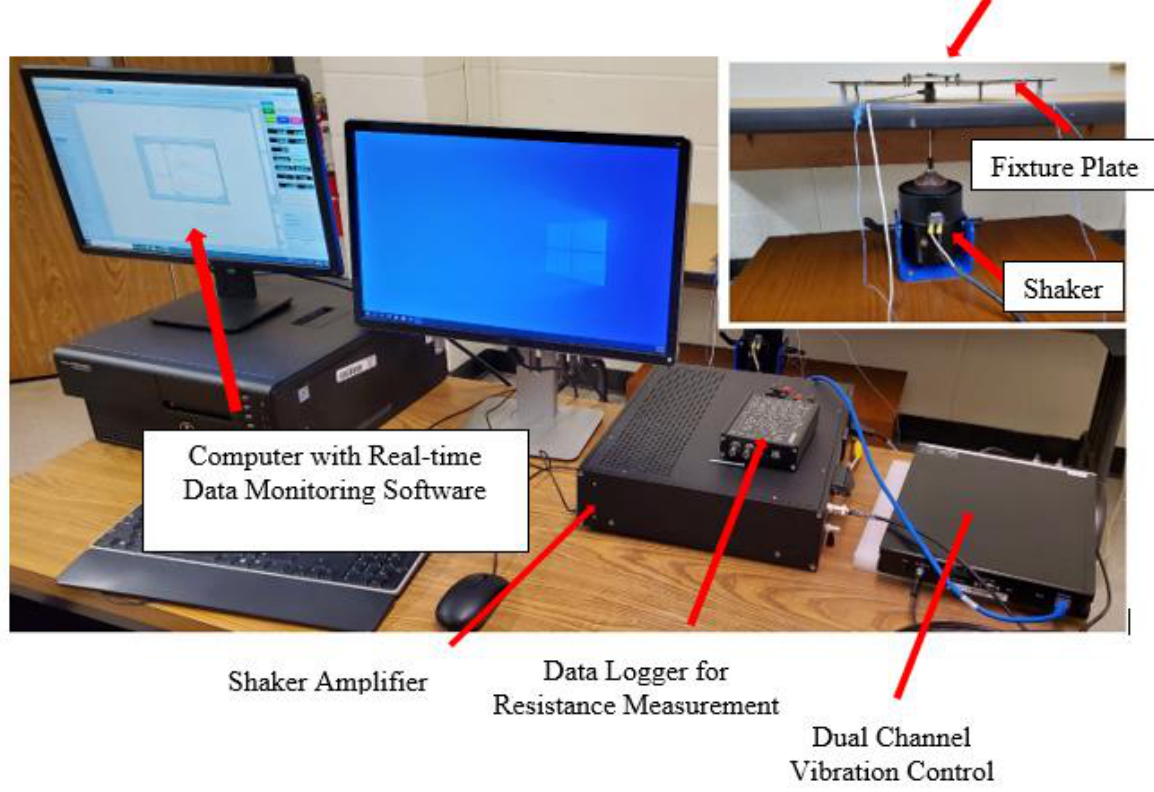
Figure 5. Detailed experimental setup.